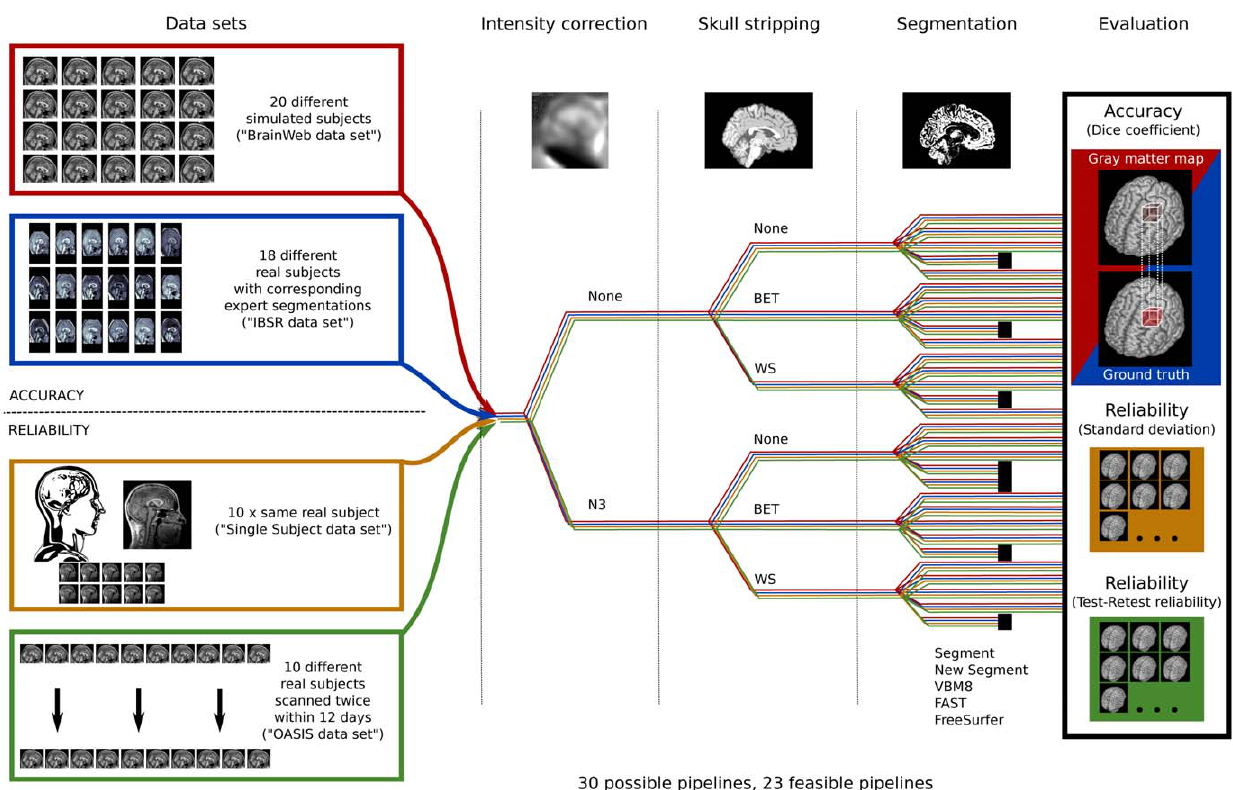
Figure 1. Overview of the study design. In total we processed fifty data sets: (i) twenty simulated brains of the Simulated Brain Database with different anatomical models (‘‘BrainWeb data set’’), (ii) 18 different real subjects with corresponding expert segmentations (‘‘IBSR data set’’), (iii) ten T1-weighted scans of the same individual (‘‘Single Subject data set’’), and (iv) ten pairs of images of subjects who were scanned twice within a maximum of twelve days (‘‘OASIS data set’’). We created in total thirty segmentation pathways where each consisted of: An intensity non-uniformity correction preprocessing step (consisting of no intensity correction or N3 ), a skull-stripping preprocessing step (consisting of no skull-stripping, BET , or WS ), and the segmentation of gray matter (via Segment , New Segment , VBM8 , FAST , or FreeSurfer ). Once created, we determined that 23 of the total constructed segmentation pathways were feasible for evaluation and these were investigated in the analysis (infeasible pathways are represented with a dot as end marker). To determine the accuracy of the different segmentation pathways we calculated the Dice coefficient for the gray matter maps and corresponding ground truth images for the twenty simulated brains and the IBSR data set. We tested the reliability of the segmentation pathways by (i) determining the variability in terms of standard deviation and coefficient of variation with respect to gray matter volume on the Single Subject data images, and (ii) by calculating the test-retest reliability with respect to gray matter volume for the OASIS data set.